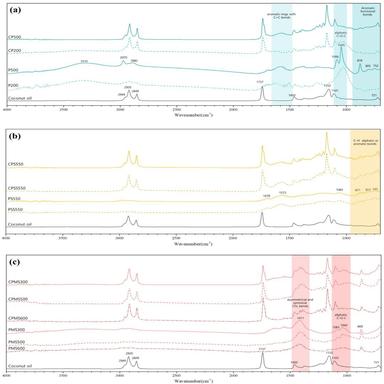
FTIR spectra of (a)P biochar (b) PS biochar and (c) PMS biochar.